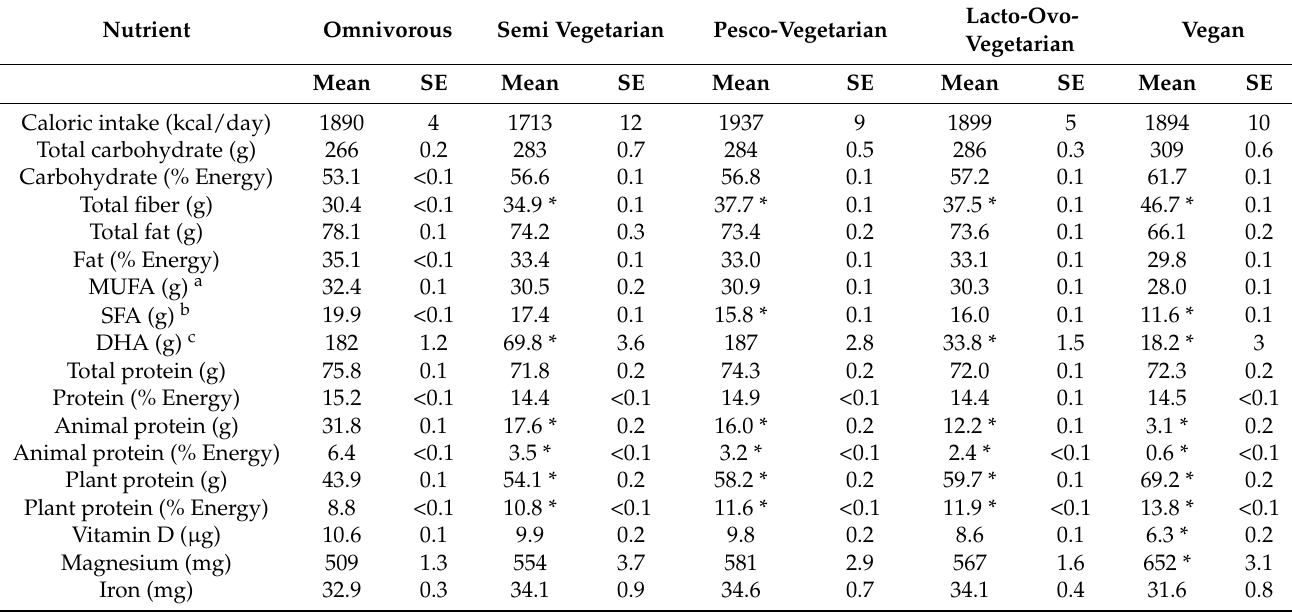
Table 2. Macronutrient and micronutrient intake of diets (adapted from [3]). Mean nutrient intake values with standard errors (SE) standardized to 2000